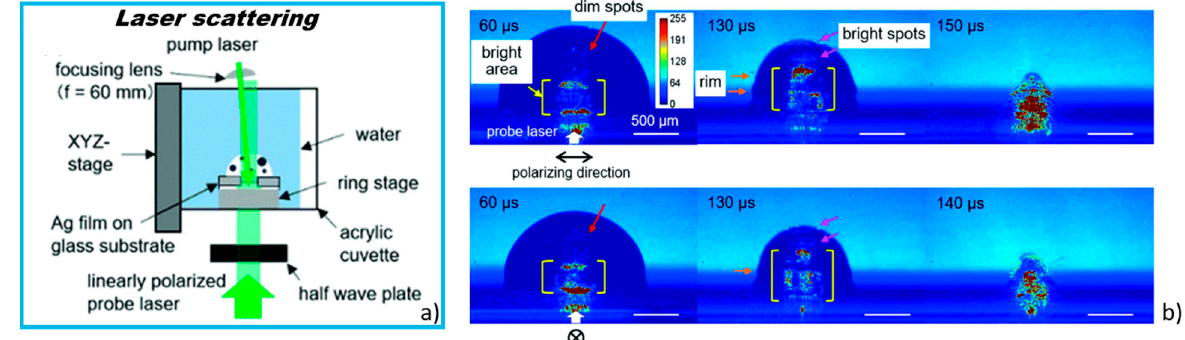
Figure 12 . ( a ) Sketch of the experimental set-up for laser-scattering technique. ( b ) Laser-scattering images superposed on the shadowgraph images at different delays after the pump pulse. The probe laser is (upper) horizontally and (lower) vertically to-paper polarized, as indicated by the arrow and cross mark. (Target = Ag film, pump laser pulse width = 5 ns, pump laser energy = 3.7 mJ, pump laser wavelength = 532 nm, probe laser pulse width = 0.8 ns, probe laser energy = 0.1 mJ, probe laser wavelength = 1064 nm,) (Reproduced from Ref. [35] with permission from the Royal Society of Chemistry).